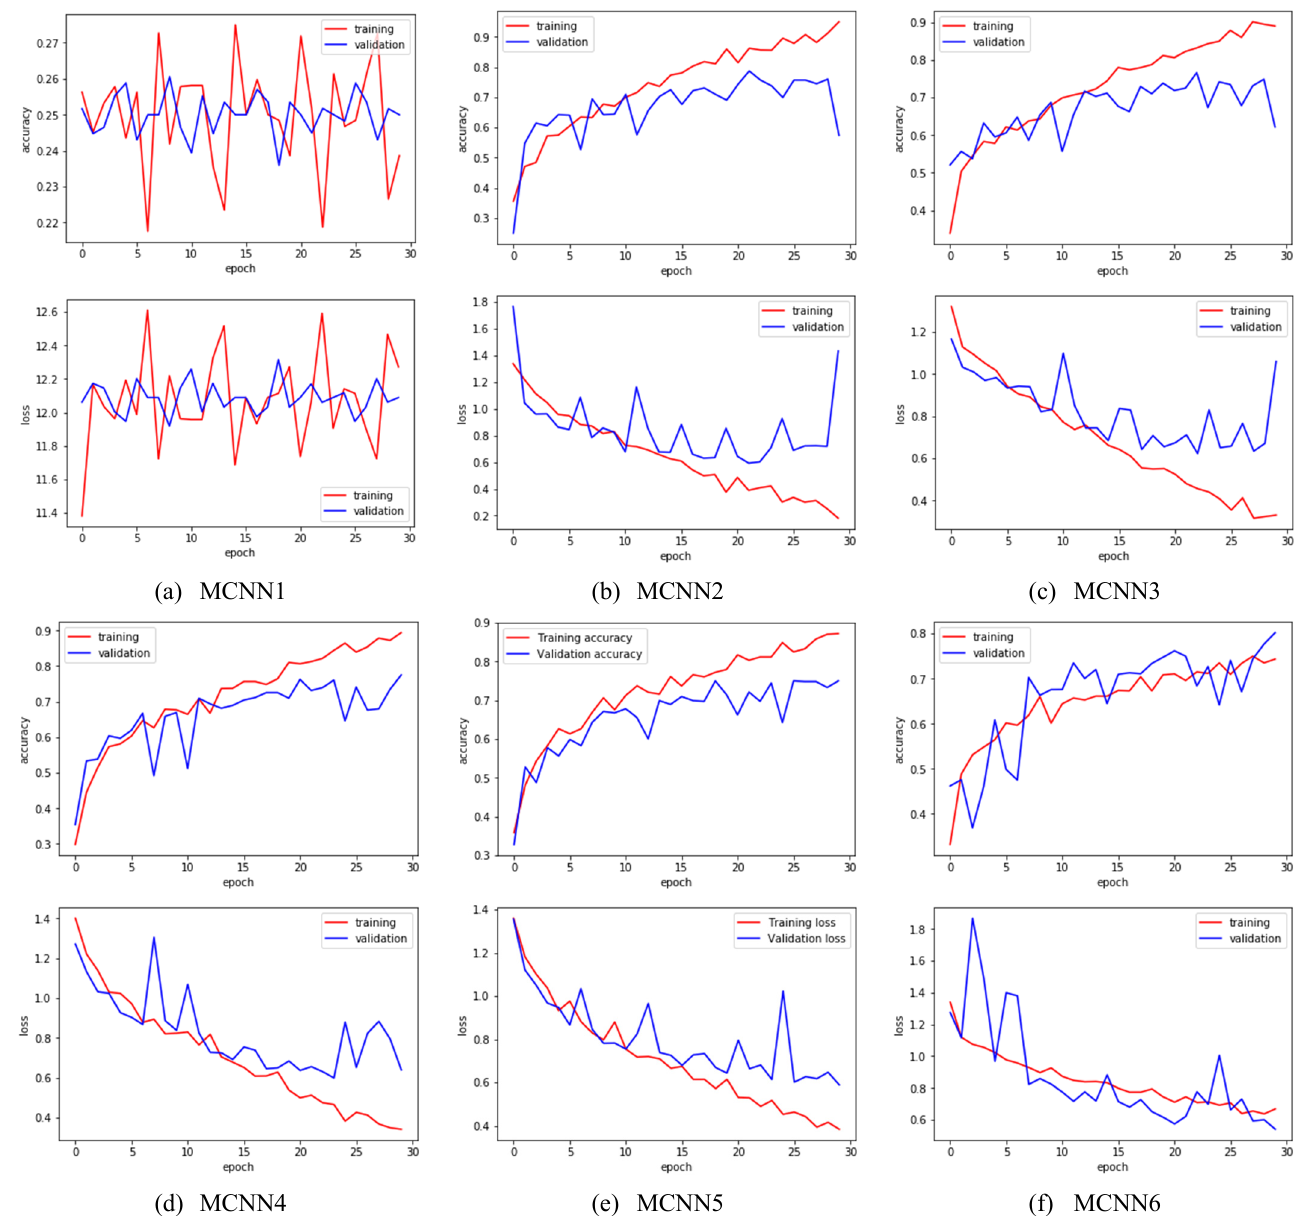
Figure 5. The accuracy and loss of the six models for training and verification of damage images.